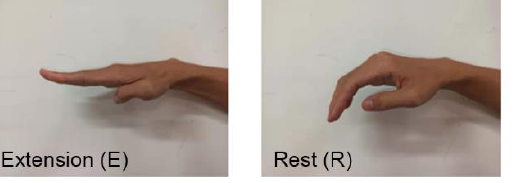
Figure 2. System diagram of the SExoG.